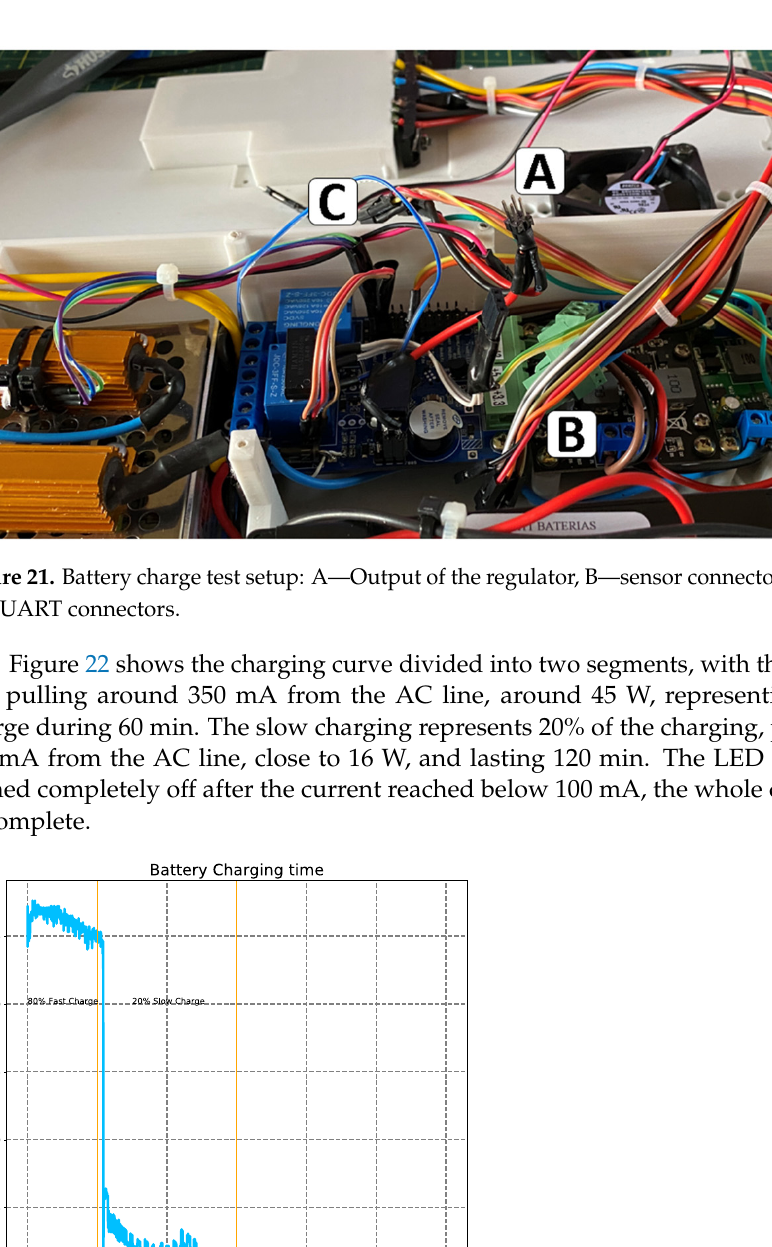
Figure 22. Graph of the battery charge time.